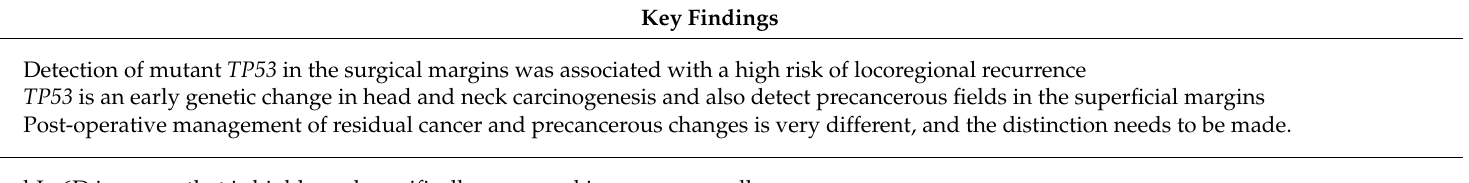
Table 1. Overview of a number of detection methods for minimal residual disease in surgical margins or liquid biopsies. Method Refs. Key